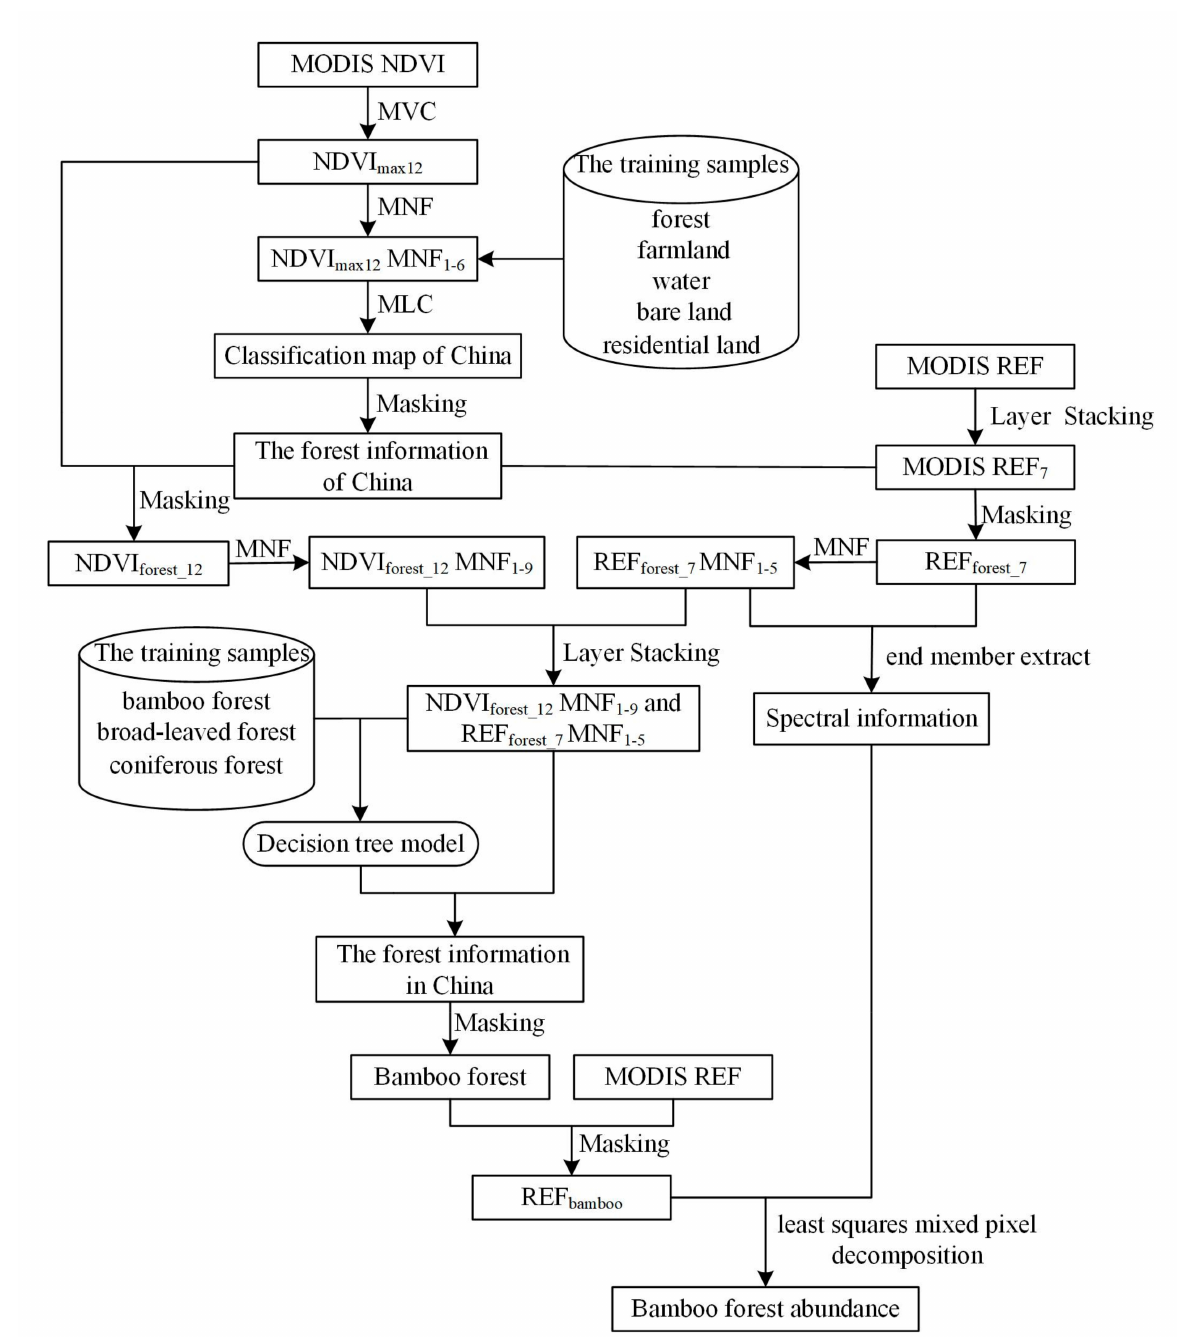
Figure 2. Flow chart of bamboo